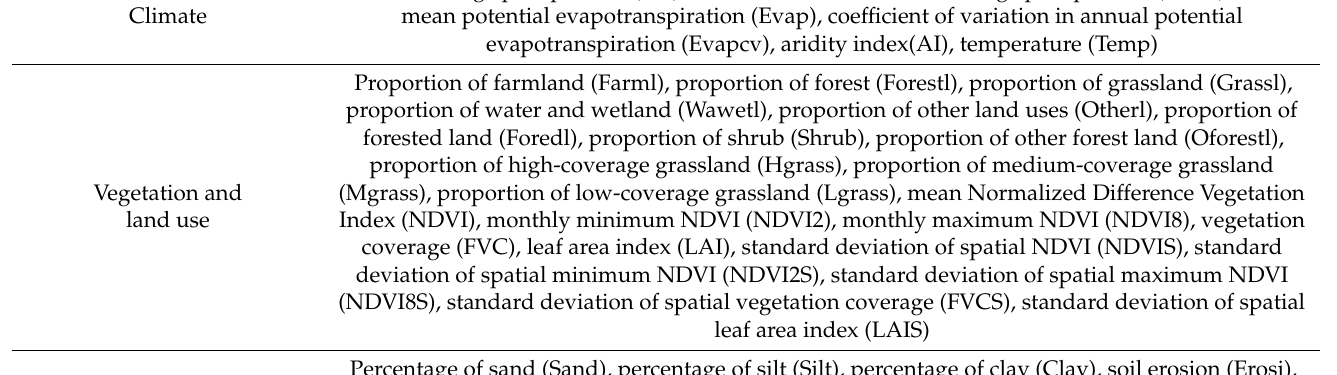
Table 2. Indices of climate and underlying surface for regionalization of hydrological model parameters.